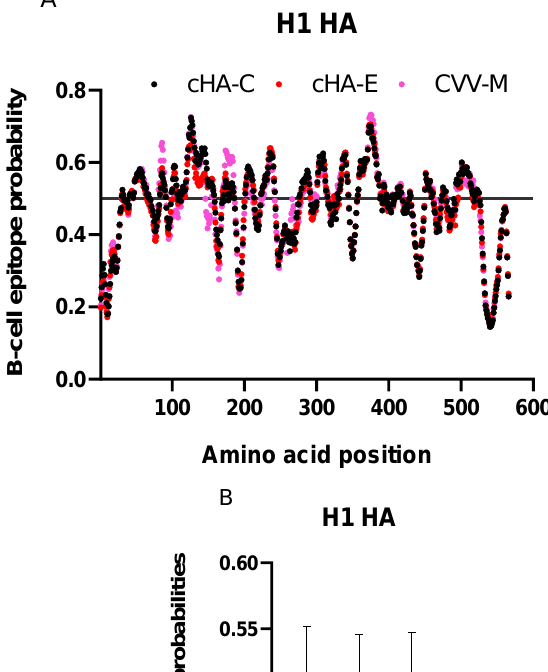
Here are common or unique epitope-based peptides altered or generated on the cHAs compared to the control, CVV-M; peptides shared by the two cHAs, cHA-C and cHA-E are indicated with *.